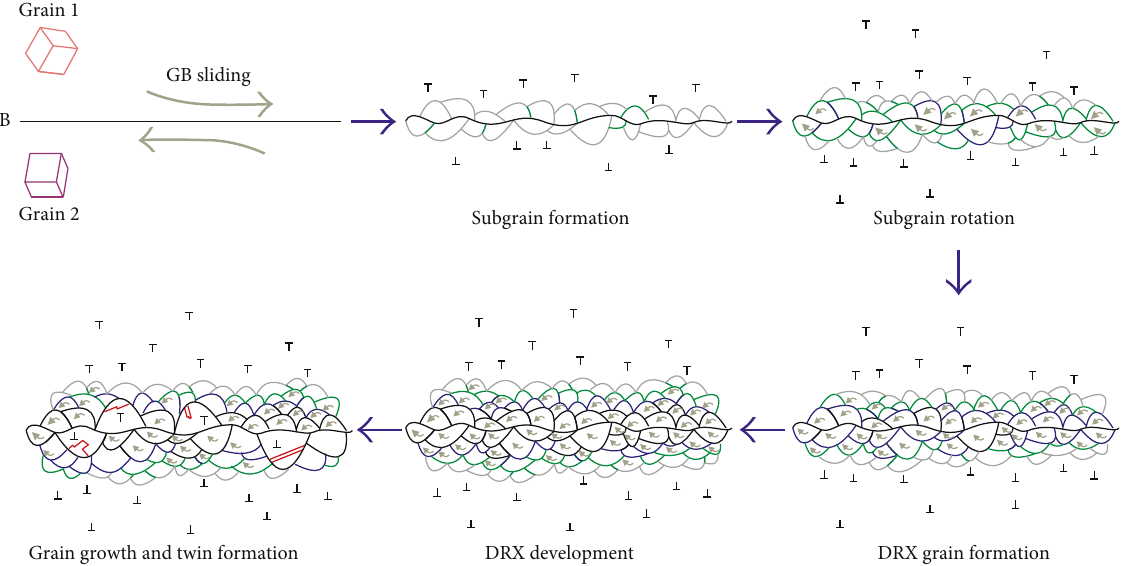
Figure 8: Schematic illustration of the nucleation mechanism of DRX for 18Mn18Cr0.6N steel compressed at a strain rate of 10 − 4 · s − 1 .